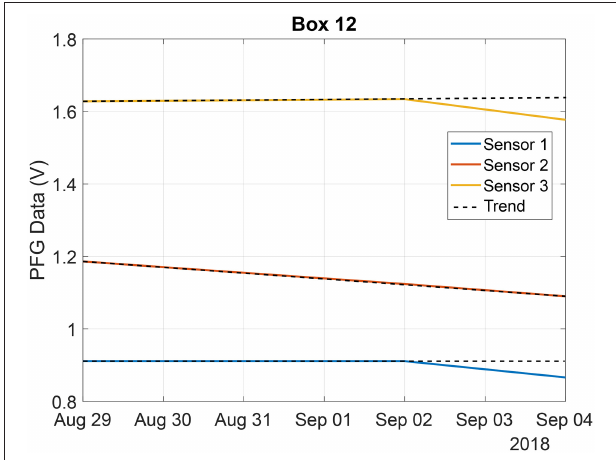
FIGURE 10 | Sensors 1 and 3 show data-logging events around the 2018 Labor Day Walk (on September 03), Sensor 2 logging did not deviate due to the event. Trend line is expected data if no event occurred on September